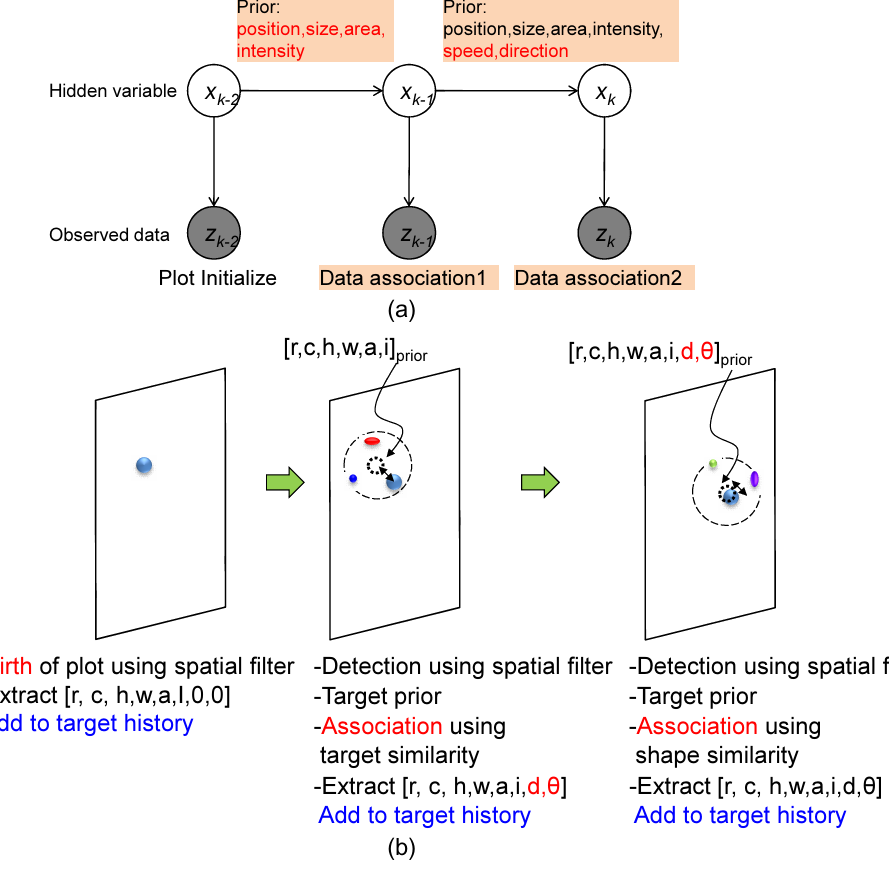
Figure 18. Concept of temporal filter using data association: ( a ) Graphical model-based representation of a three-plot correlation filter; ( b ) implementation procedures. The first frame is used to generate initial plots without prior knowledge. In the second frame, the prior target attribute is used for data association. In the third frame, the prior motion is also used during data